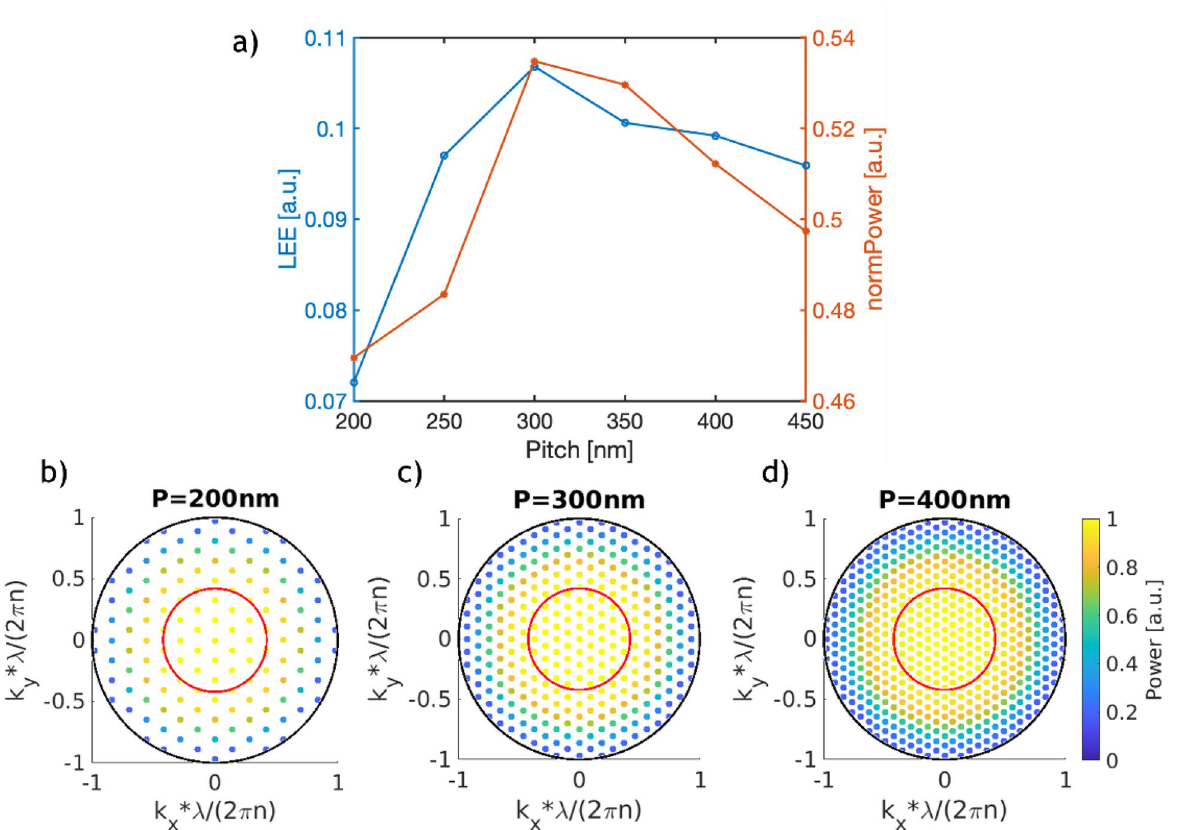
Figure 4. ( a ) LEE and normalized power emitter into the substrate as a function of the nanostructure pitch. ( b – d ) Normalized power distribution of modes emitted into the substrate for a pitch of 200 nm, 300 nm and 400 nm. The black outer circle represents the boundary of propagating modes, while the red inner circle represents the escape cone due to TIR.